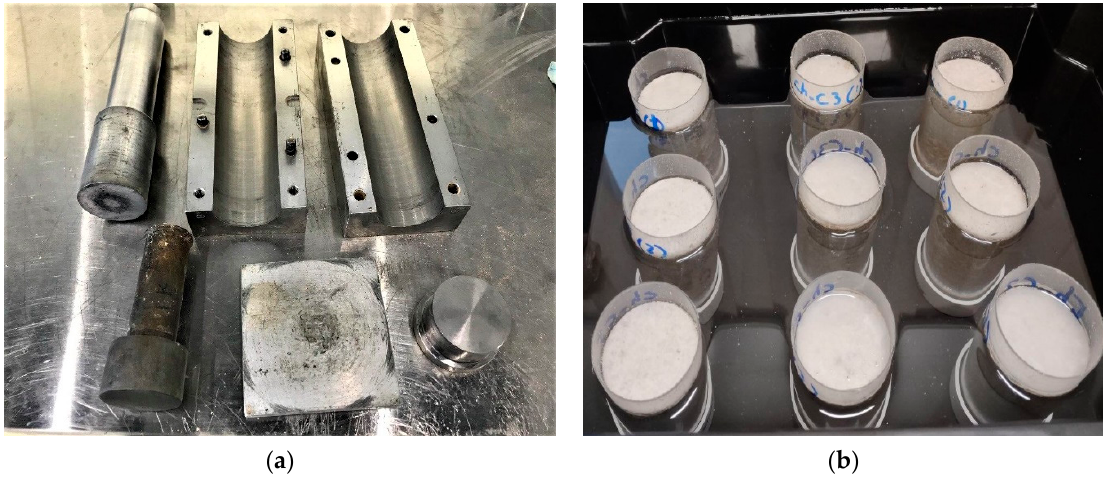
Figure A1. Compaction curves for sand-kaolinite mixtures.